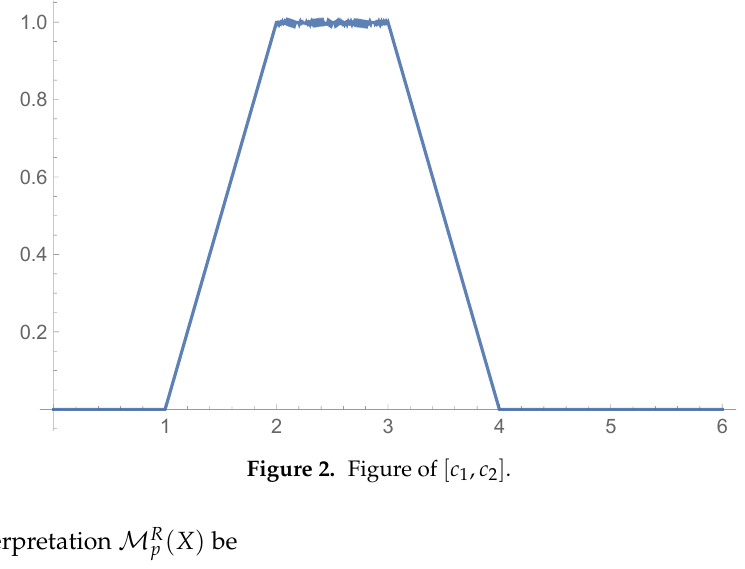
Figure 2. Figure of [ c 1 , c 2 ] .